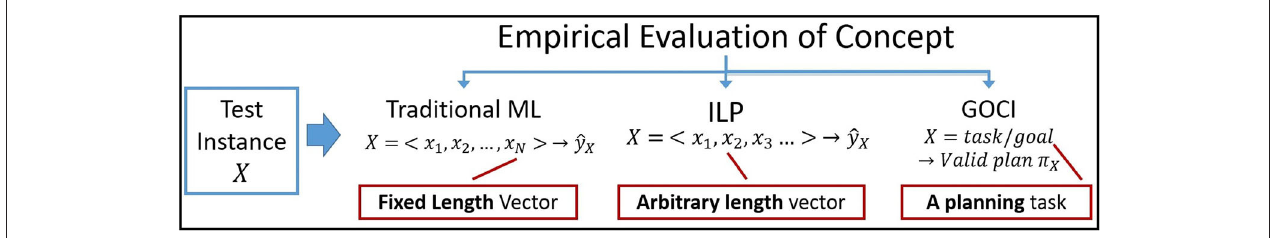
FIGURE 4 | Difference in evaluation of a concept instance across different learning paradigms.